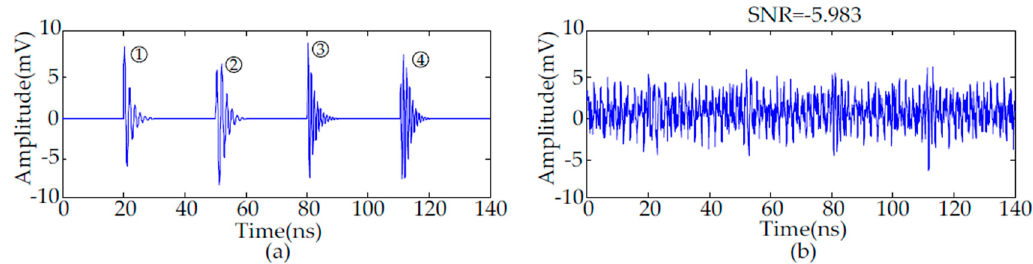
Figure 1. Simulated UHF PD signals: ( a ) Simulated PD signals; ( b ) Simulated noisy PD signals.